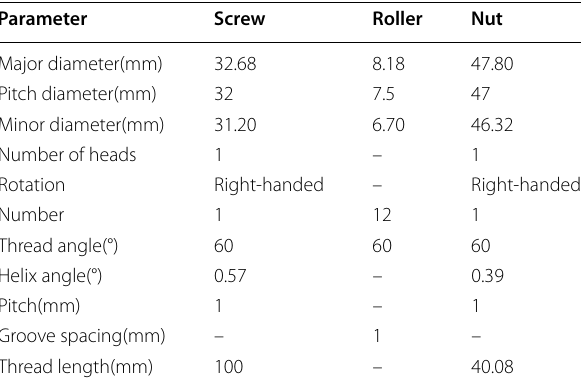
Table 1 Main structural parameters of components